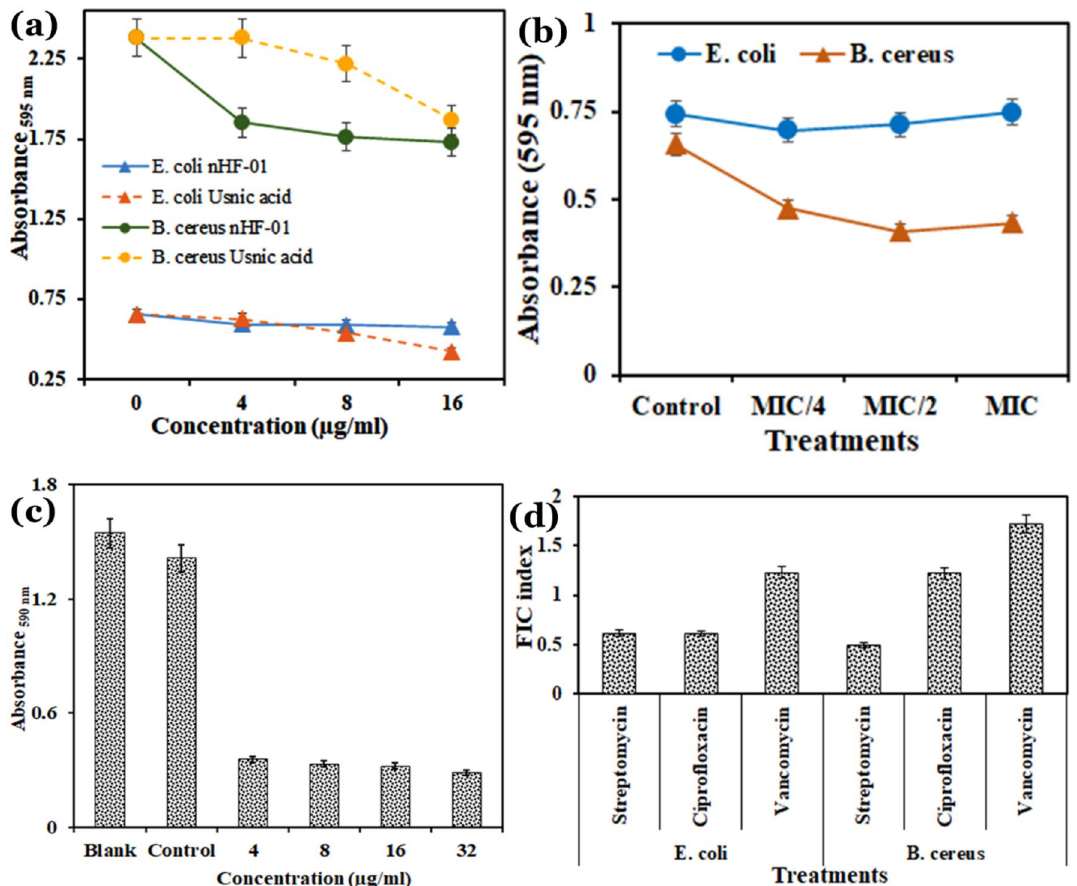
Figure 6. Effect of the 5-butyl-2-Pyridinecarboxylic acid on ( a ) biofilm inhibition; ( b ) biofilm destabilization; ( c ) cytotoxicity assay against A549 cell line; ( d ) synergistic effects with three common antibiotics, ciprofloxacin, streptomycin and